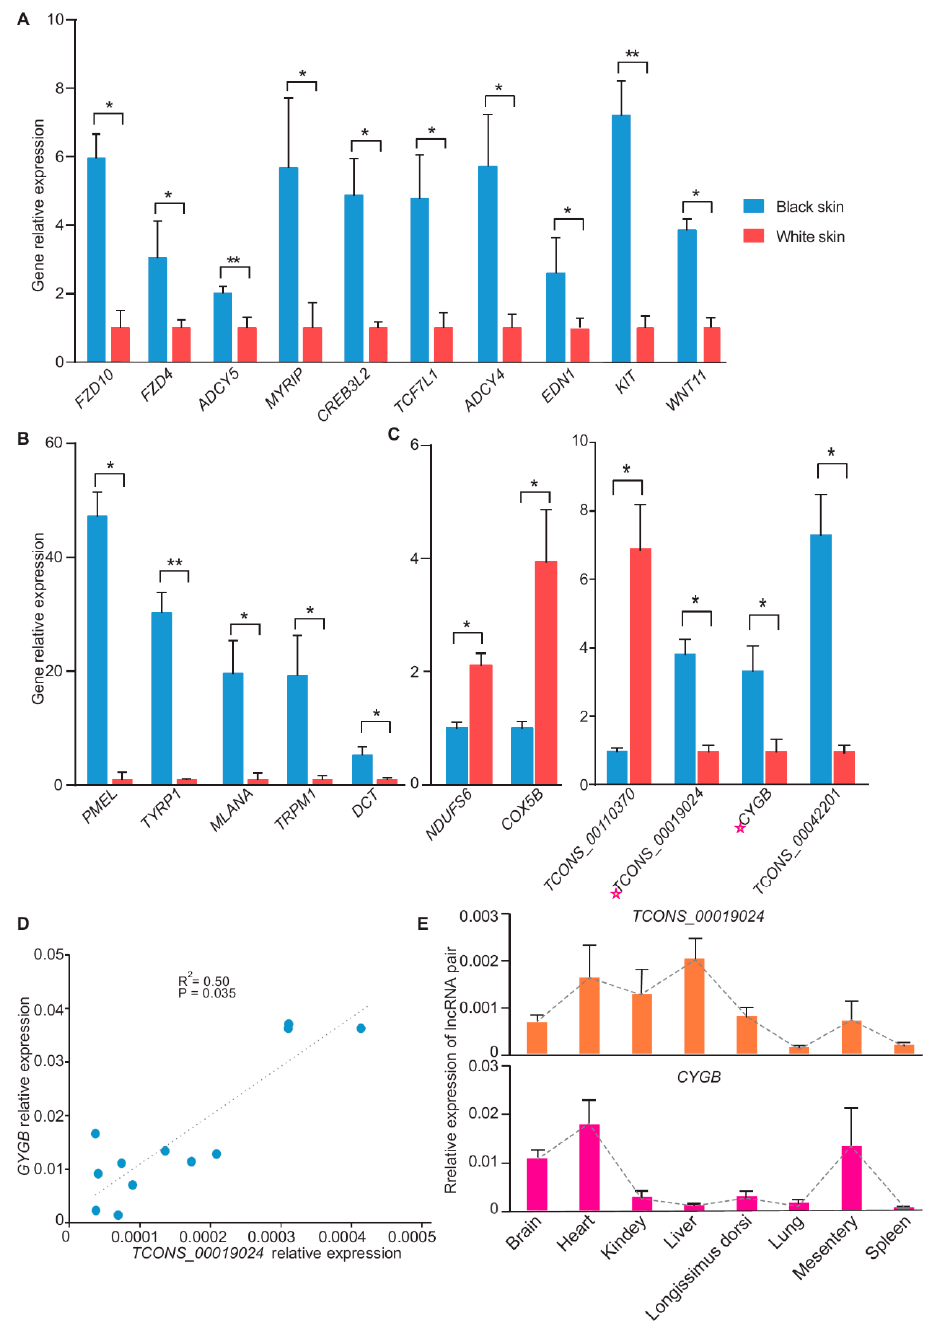
Figure 5. RT-PCR validation of the differentially expressed mRNAs and lncRNAs. ( A ) RT-PCR validation results of 10 coat color genes ( n = 3). ( B ) RT-PCR validation results of melanocyte-specific expression gene ( n = 3). ( C ) RT-PCR validation results of mRNA and lncRNA that were differentially expressed in the skin ( n = 3). The lncRNA TCONS_00019024 and its target gene CYGB were marked utilizing a pink star. ( D ) Correlation curve of TCONS_00019024 / CYGB . RT-PCR data from skins were used to create a correlation curve ( n = 6). Linear correlation coefficient of TCONS_00019024 / CYGB was 0.71 (R 2 = 0.50, p = 0.035). ( E ) Relative expression of TCONS_00019024 and CYGB in 8 tissues ( n = 3). * p -value < 0.05. ** p -value < 0.01.